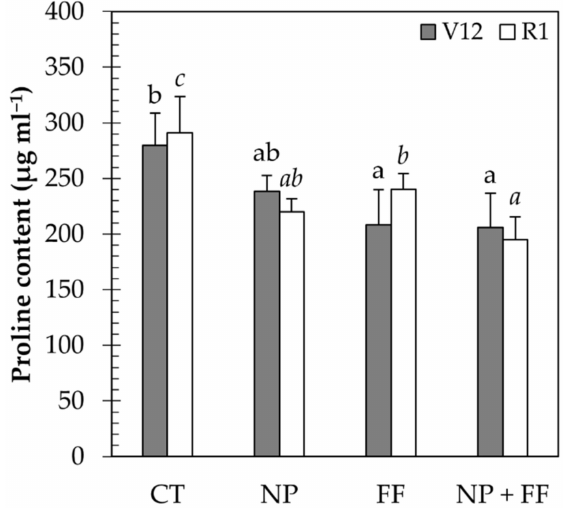
Figure 5. Proline content of maize leaves due to each treatment at different phenological stages (V12 and R1). Data represent mean ± SD (n = 5); CT: untreated control; FF: foliar fertilizer; NP: nitrapyrin; NP + FF: joint treatment of nitrapyrin and foliar fertilizer. Different lowercase letters denote significant differences (one-way ANOVA and Duncan’s multiple range test, p ≤ 0.05) between the different